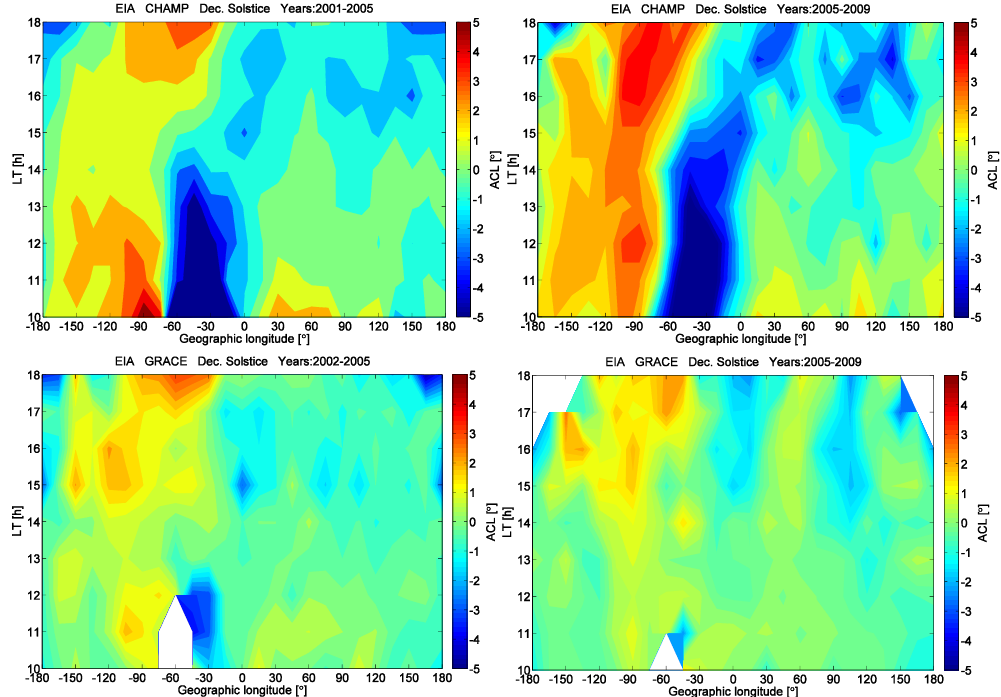
Fig. 5. Same as Fig. 4, but for December solstice months. 630